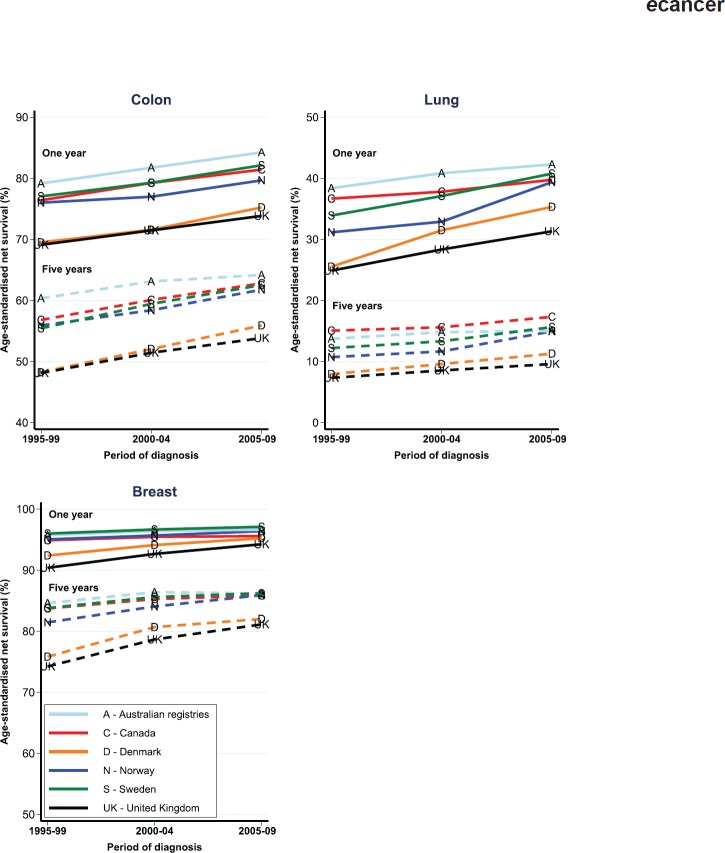
Data from the CONCORD-2 study shows evidence of improving one year and five year survival for patients from six jurisdictions. Comparison of the UK outcomes for colon cancer, lung cancer and breast cancer show that, despite continued improvement in the UK, there is still a lag behind the results of the five comparator jurisdictions. Data provided and prepared by Professor Michel Coleman and the CONCORD-2 team. [Allemani C, Weir HK and Carreira H et al (2015) Global surveillance of cancer survival 1995-2009: analysis of individual data for 25,676,887 patients from 279 population-based registries in 67 countries (CONCORD-2) Lancet 385(9972) 977–1010 DOI: 10.1016/S0140-6736(14)62038-9]